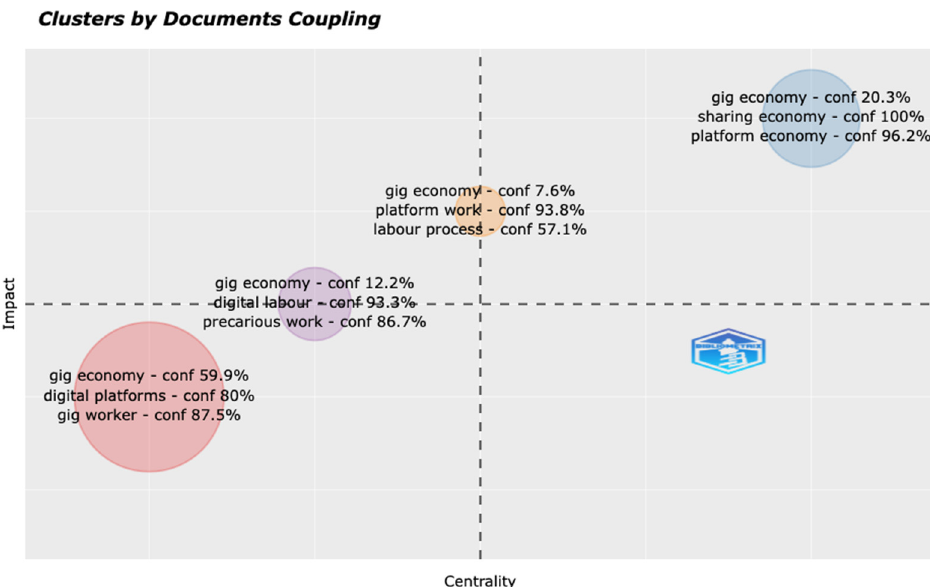
Figure 7. Cluster coupling is evaluated by the authors’ keywords. Source: RStudio results.